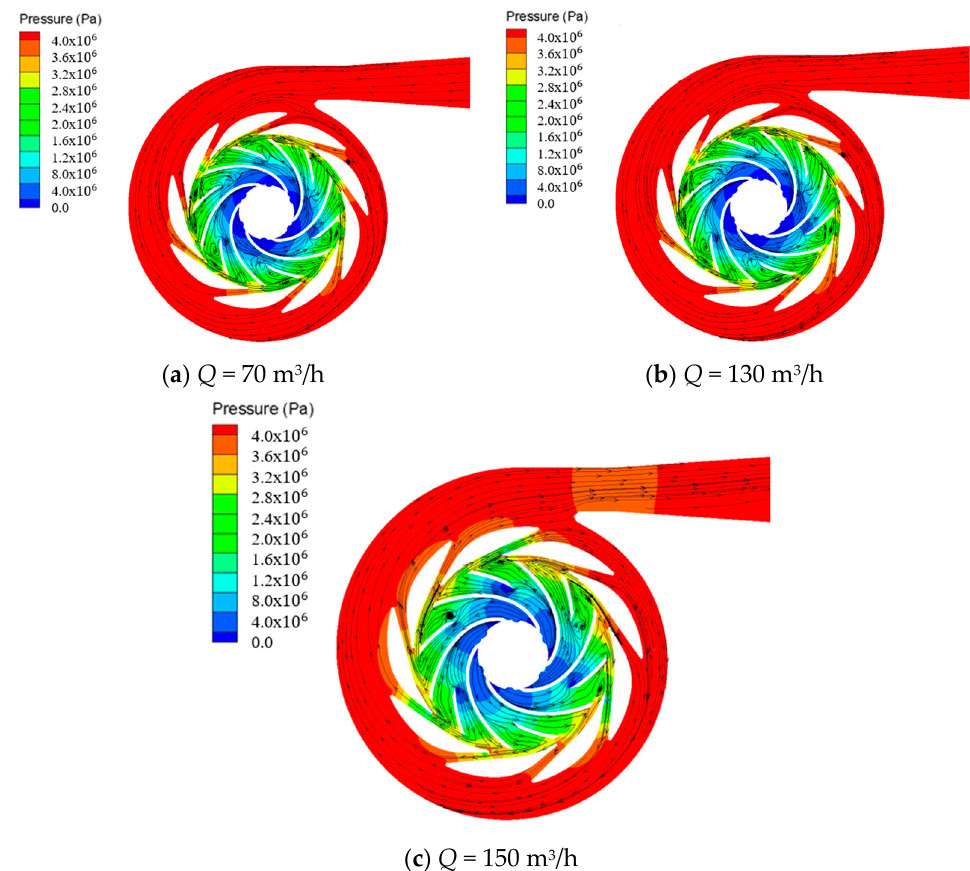
Figure 10. Figure of the pressure distribution and streamline.